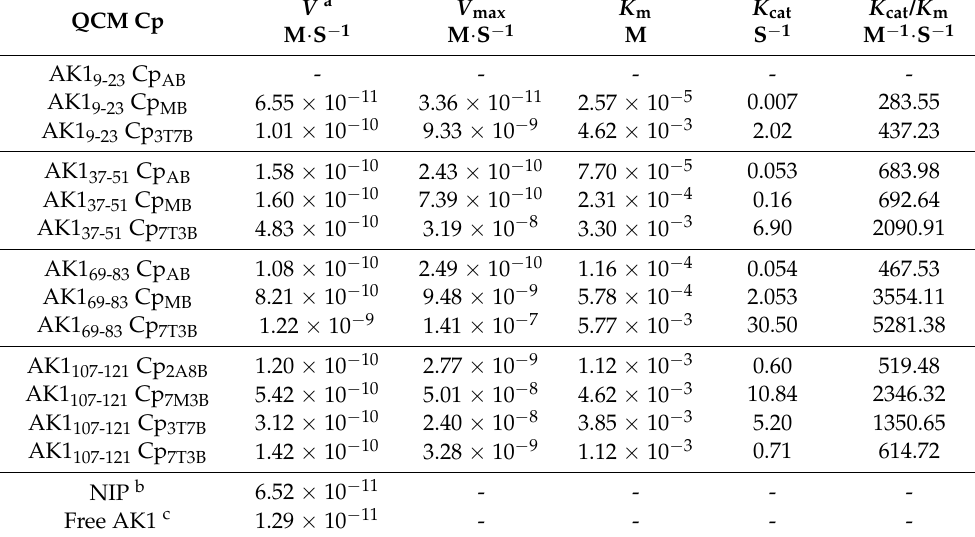
Table 3. Summary of the calculated kinetic parameters of catalytic